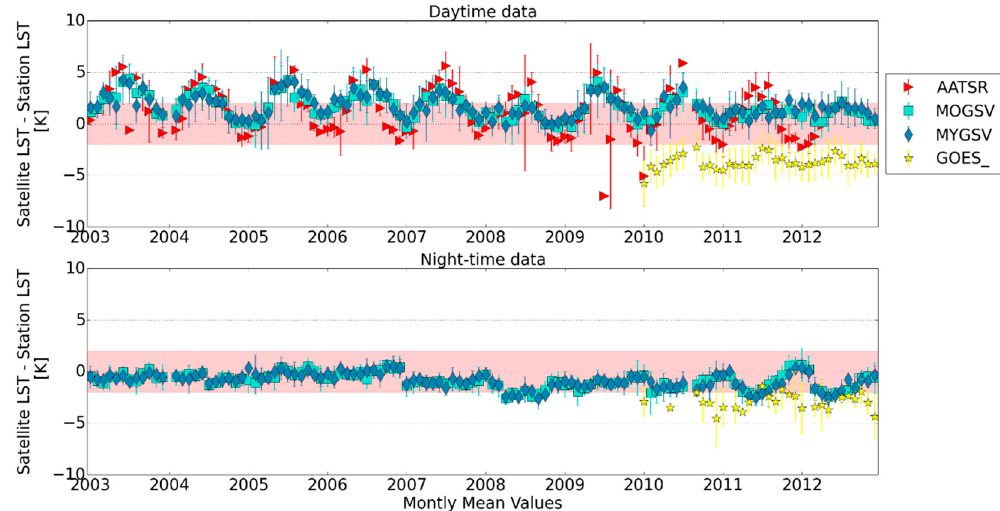
Figure 14. Monthly median accuracies (satellite LST–station LST) over DRA station for the years 2003–2012. The upper plot shows daytime and the lower night-time data. The ranges shaded in red indicate the ±2.0 K accuracy range.